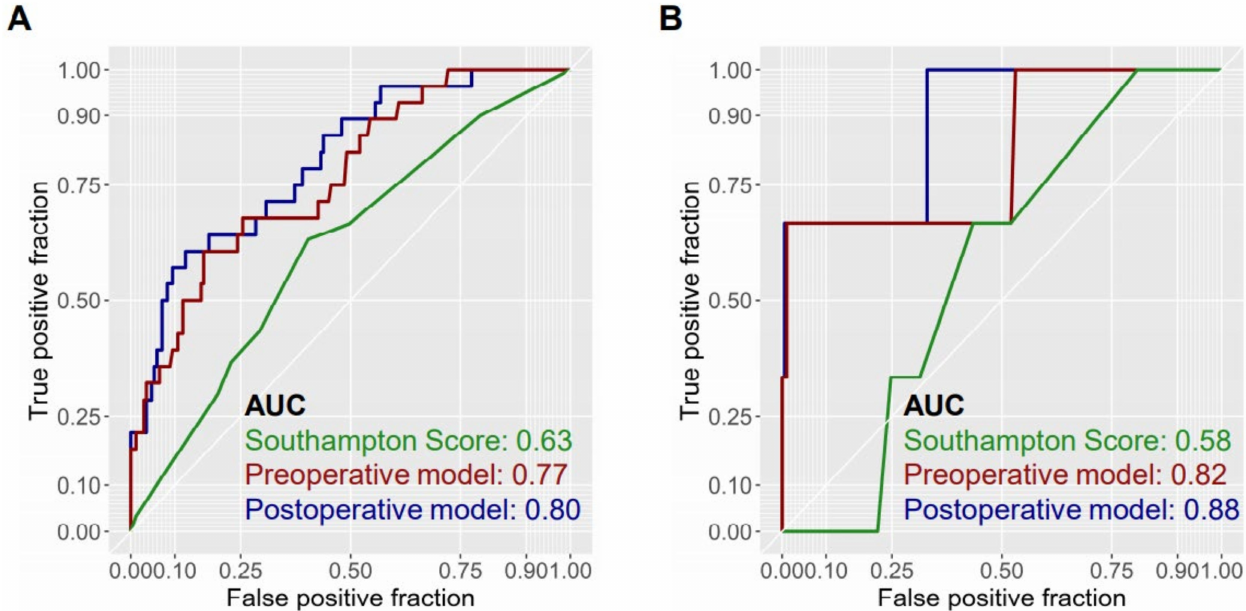
Figure 2. Comparison of predictive models. Comparative analysis of the AUC of the preoperative (red) and postoperative (blue) models compared to the Southampton score (green) both for the primary endpoint of major complications ( A ) and the secondary endpoint of mortality ( B ) reveals the two defined models to have a higher predictive value. AUC computation and model generation are based on the dataset, omitting cases with missing